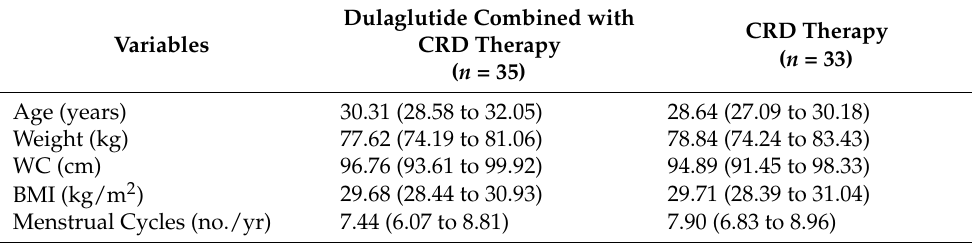
Table 1. Baseline characteristics of overweight/obese patients with